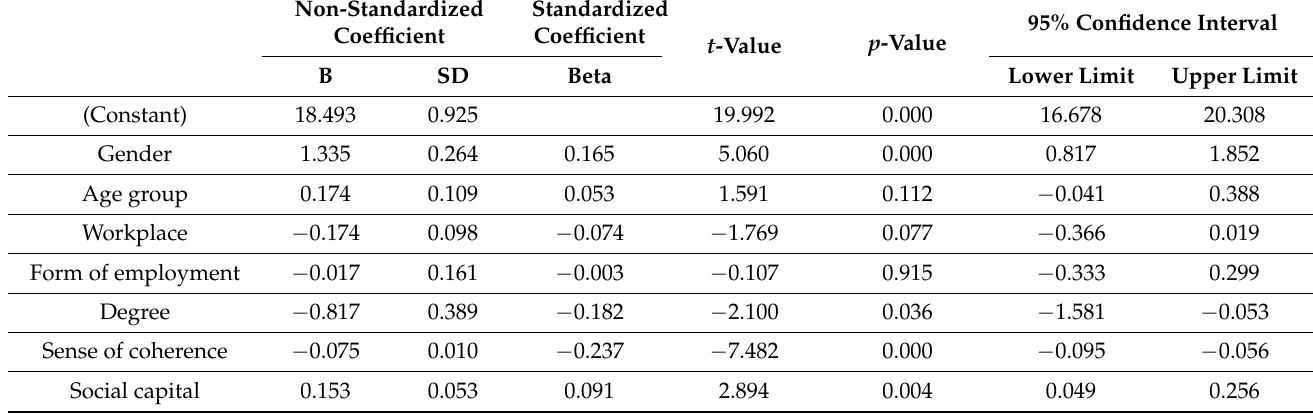
Table 4. Fear/anxiety regarding COVID-19 and influencing factors (linear multivariate regression